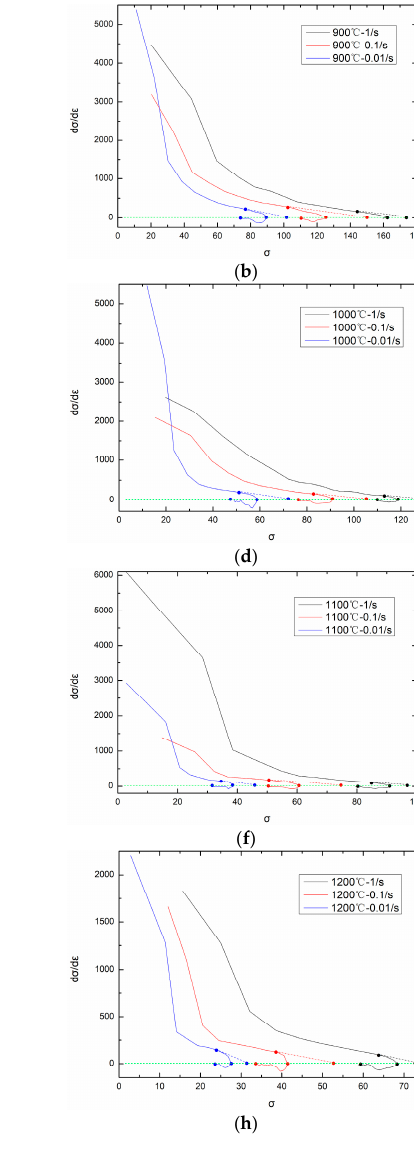
Figure 8. d σ /d ε - σ curves on different temperatures: ( a ) 850 °C; ( b ) 900 °C; ( c ) 950 °C; ( d ) 1000 °C; ( e ) 1050 °C; ( f ) 1100 °C; ( g ) 1150 °C; ( h ) 1200 °C.